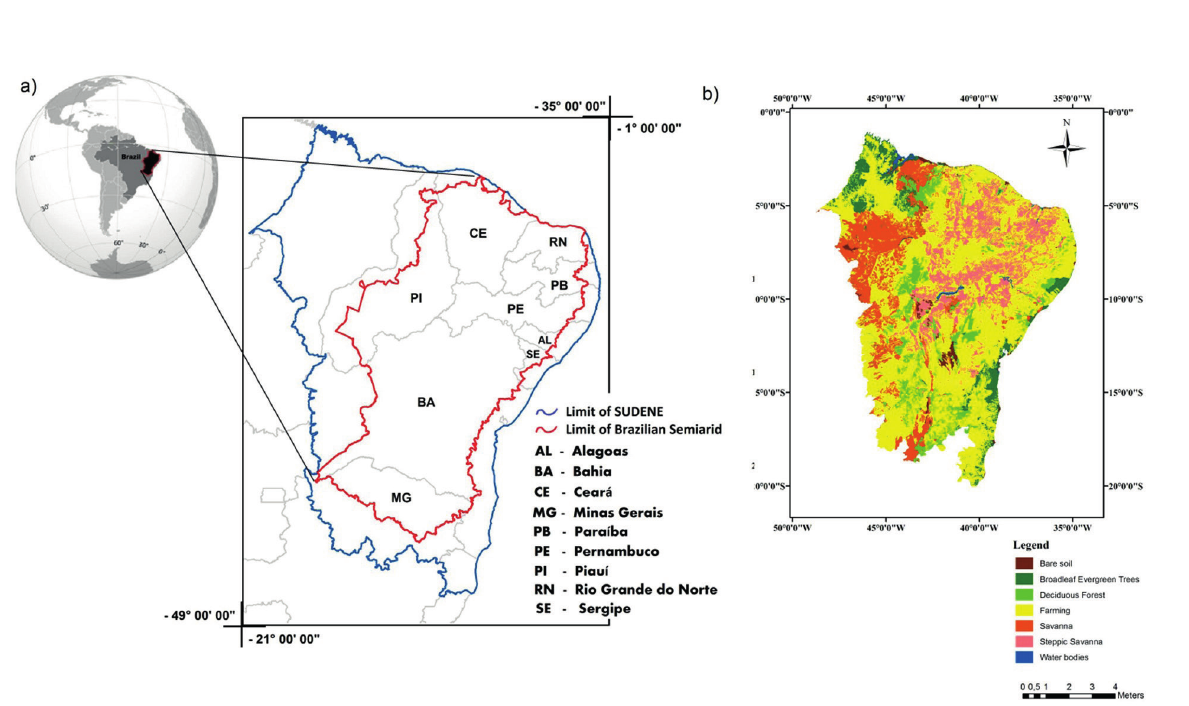
Figure 1 - Geographic limits of the monitored area (SUDENE’s acting area - blue line; limits of the Brazilian semiarid region - red line) ( a ); and land use and land cover map of the Brazilian Northeast (Source: Adapted from Vieira et al. 2013) ( b